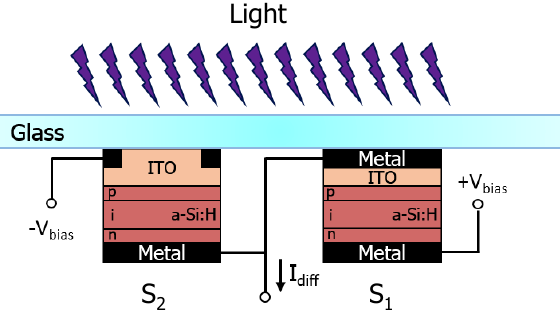
Figure 1. Device cross-section. S 1 is the ligth-shielded junction and therefore it is sensitive only to temperature, while diode S 2 is sensitive to both temperature and light.